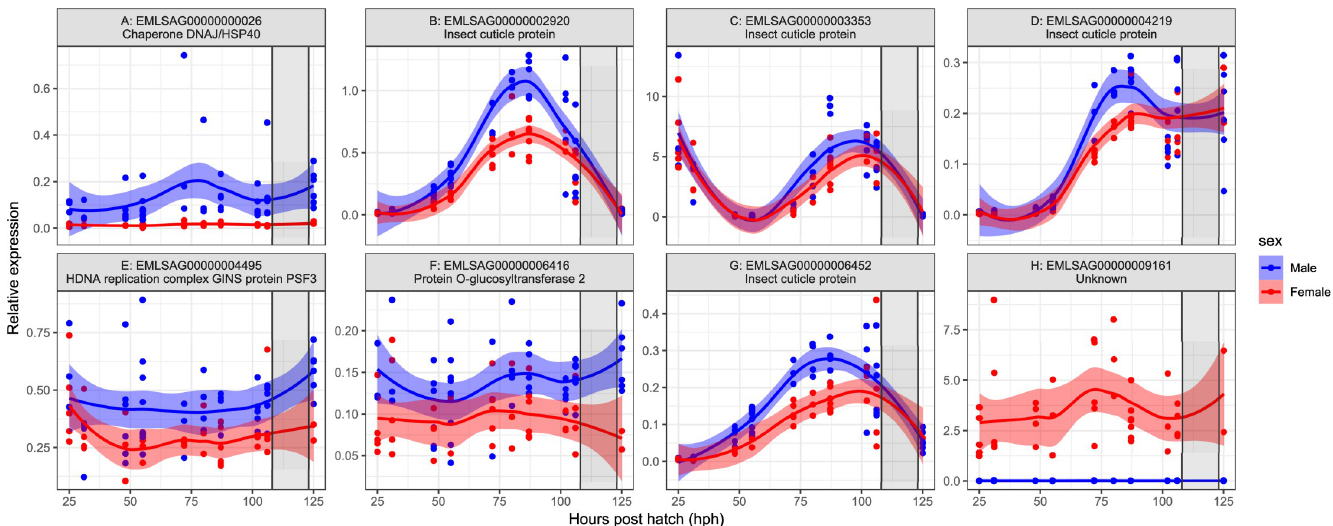
Fig 4. Expression of selected genes of male and female individual salmon lice during the nauplius II stage. Offspring from one egg string pair was sampled at different time points during development. The sex of every animal was determined, and several target genes were measured using qPCRs. Sampling started during the nauplius II stage and stopped in the copepodid stage. The grey rectangle marks the time frame in which molting from nauplius II to copepodid has taken place.